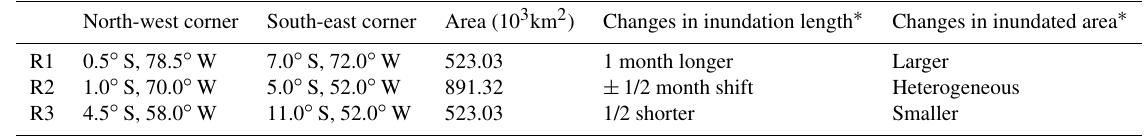
Table 5. Location and characteristics of the three